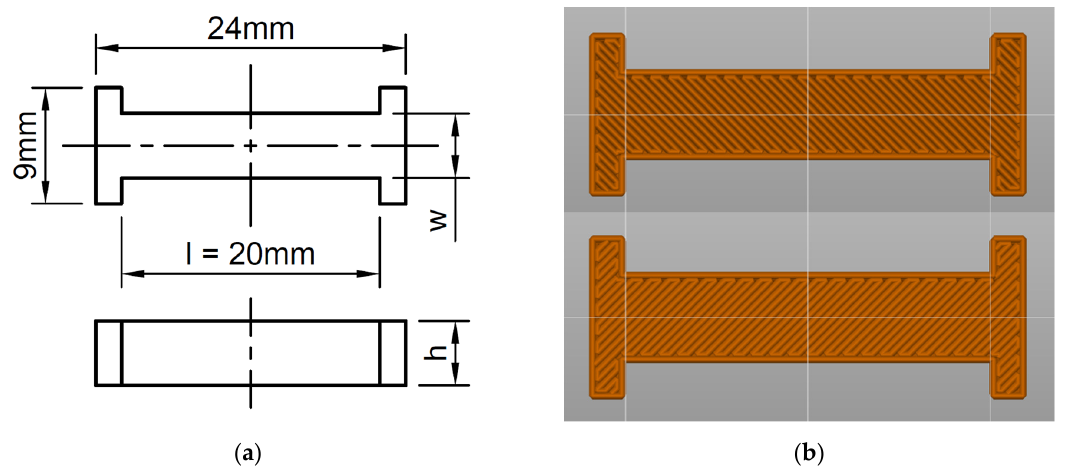
Figure 1. ( a ) Schematic drawing with dimensions of 3D printed samples for electrical measurements: top and side view. Dimensions of the samples: width ( w ) 5 mm, height ( h ) 5 mm, measurement length ( l ) 20 mm; ( b ) Image exported from the slicer software illustrating printing infill pattern for the sample layer n and n + 1 (45° and − 45°, respectively).